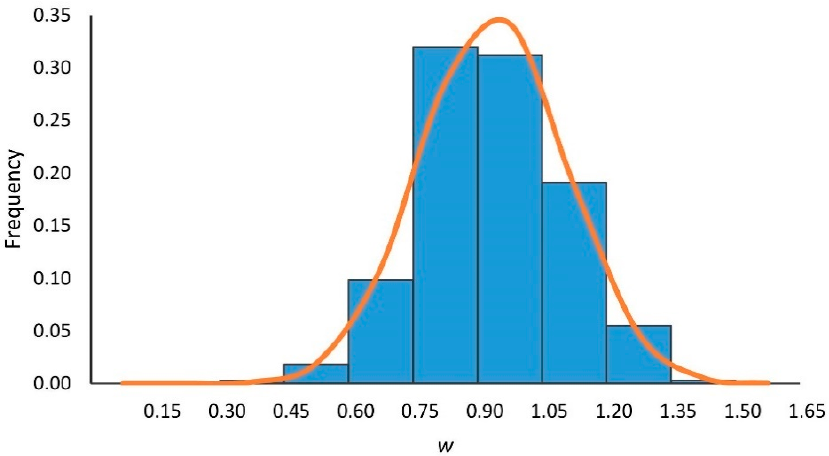
Figure 4. Histogram of the nondimensional streamflow data fitted to the normal probability distribution. Table 6. Normalization of monthly streamflow data